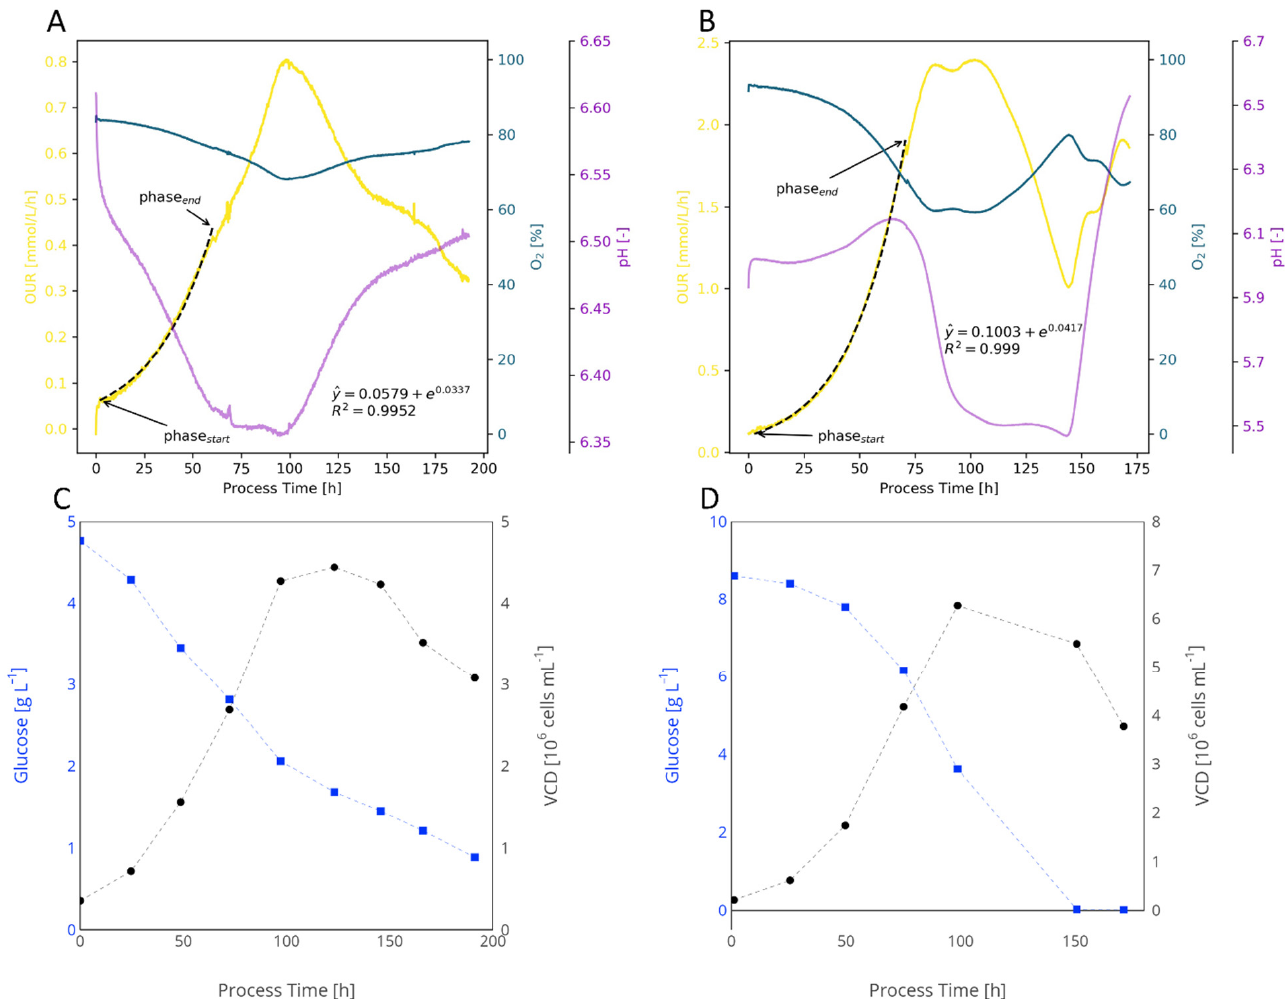
Figure A3. Evaluation of HEK cells in 250 mL shake flasks with 80 mL working volume ( A , C ) and High Five cells in 500 mL shake flasks with 100 mL working volume ( B , D ). Both cultivations were performed with a shaking rate of 130 rpm and a shaking diameter of 50 mm. The OUR signal (yellow line) was used for growth rate calculation, resulting in µ OUR, auto. = 0.00337 h − 1 for HEK and Table 30: textcomp Currency Symbols